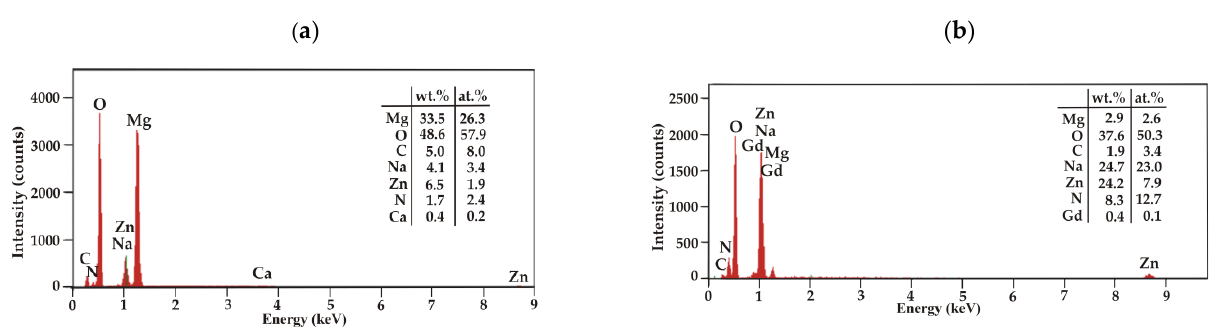
Figure 3. EDS analysis for casein coatings applied to ( a ) MgCa2Zn1 and ( b ) MgCa2Zn1Gd3 alloys.